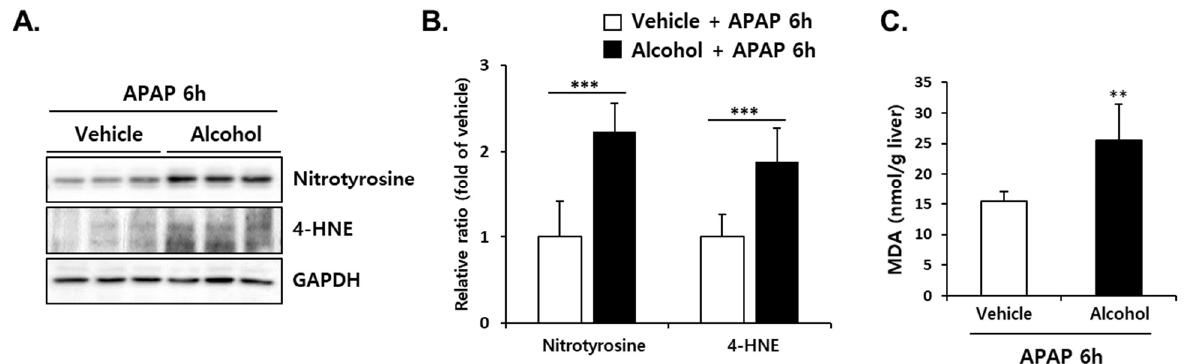
Figure 6. Alcohol binges enhanced oxidative stress in the liver of mice. Three consecutive doses of alcohol (5 g/kg, n = 5) or vehicle ( n = 5) were administered orally to mice at 12 h intervals. Twelve hours later, following the last alcohol dose, APAP (300 mg/kg) was administered orally to mice. The mice were euthanized 6 h after APAP administration (APAP 6 h). ( A ) At 6 h after APAP administration, the levels of oxidized proteins of nitrotyrosine and 4-hydroxynonenal (4-HNE) were detected. GAPDH was used as the loading control. ( B ) The expression levels of proteins were normalized to that of GAPDH. ( C ) Hepatic malondialdehyde (MDA) levels were detected 6 h after APAP administration (APAP 6 h). The results are expressed as the mean ± SD. **, *** Significantly different from the vehicle + APAP 6 h group (Student’s t test, p < 0.01 and p < 0.001, respectively).